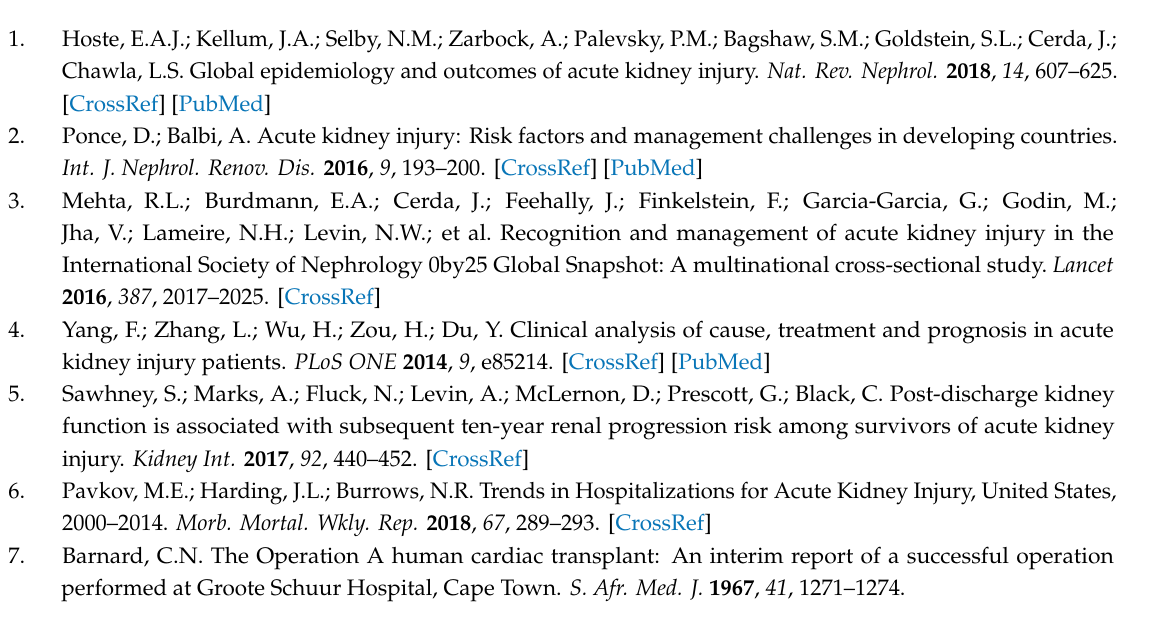
Figure S1. Forest plots of the included studies assessing the pooled OR of hospital mortality among patients undergoing cardiac transplantation with AKI limited to studies with confounder-adjusted analysis, Figure S2. Forest plots of the included studies assessing the pooled OR of hospital mortality among patients undergoing cardiac transplantation with AKI requiring RRT limited to studies with confounder-adjusted analysis, Figure S3. Forest plots of the included studies assessing the pooled OR of 1-year mortality among patients undergoing cardiac transplantation with AKI, Figure S4. Forest plots of the included studies assessing the pooled OR of 1-year mortality among patients undergoing cardiac transplantation with AKI requiring RRT, Figure S5. Forest plots of the included studies assessing the pooled OR of 1-year mortality among patients undergoing cardiac transplantation with AKI limited to studies with confounder-adjusted analysis, Figure S6. Forest plots of the included studies assessing the pooled OR of 1-year mortality among patients undergoing cardiac transplantation with AKI requiring RRT limited to studies with confounder-adjusted analysis, Figure S7. Funnel plot evaluating for publication bias evaluating hospital mortality (and / or 90-day mortality) of AKI among patients undergoing cardiac transplantation, Figure S8. Funnel plot evaluating for publication bias evaluating 1-year mortality of AKI among patients undergoing cardiac